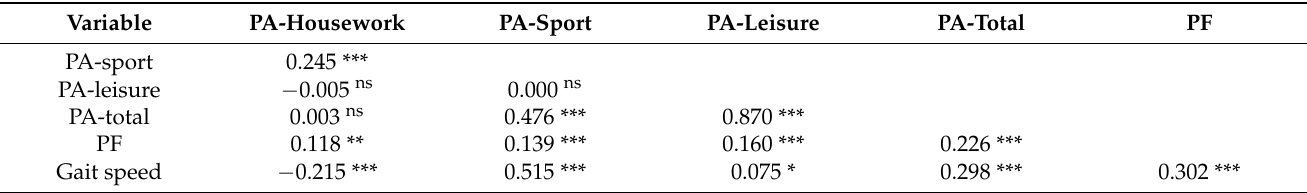
Table 2. Associations between analyzed variables.